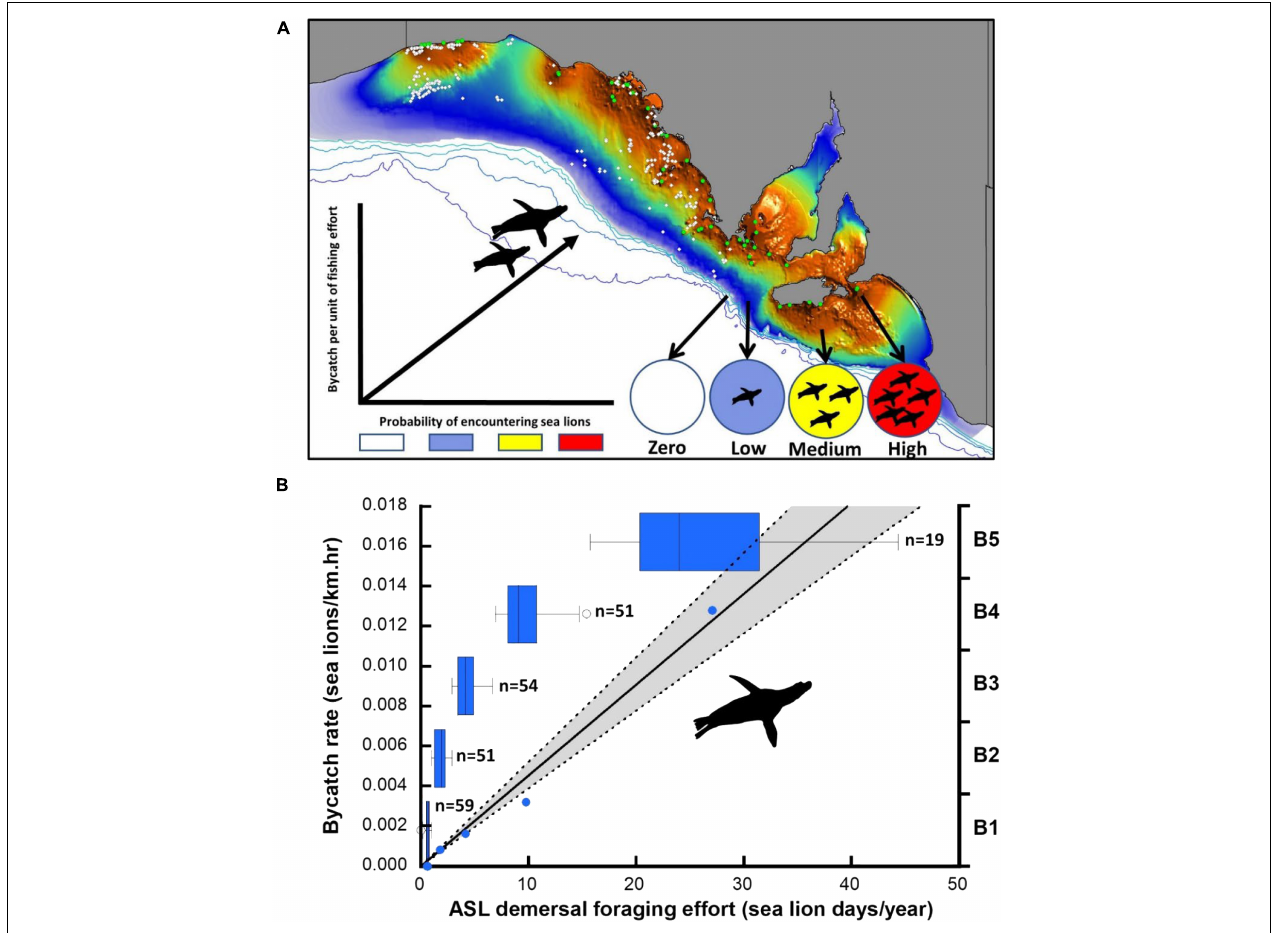
FIGURE 3 | Distribution of observed net-sets (open circles) in the gillnet sector of the GHAT fishery off SA relative to the species distribution model of ASL demersal foraging effort (A) . Colony locations (green circles) and the expected relationship between the probability of encountering sea lions and the bycatch rate per unit of fishing effort are indicated. (B) Linear model of the observed bycatch rate per unit of fishing effort and estimated ASL demersal foraging effort for the optimal 5-bin model (B1-B5), including box-plots to illustrate the sample size (observed net-sets) and foraging effort range differences of successive bins (blue circles are the data points underpinning the regression, 95% CL